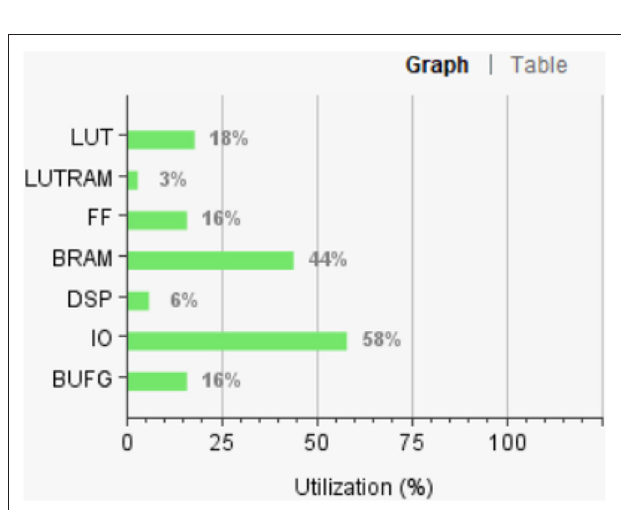
FIGURE 12 | Resource utilization of the proposed